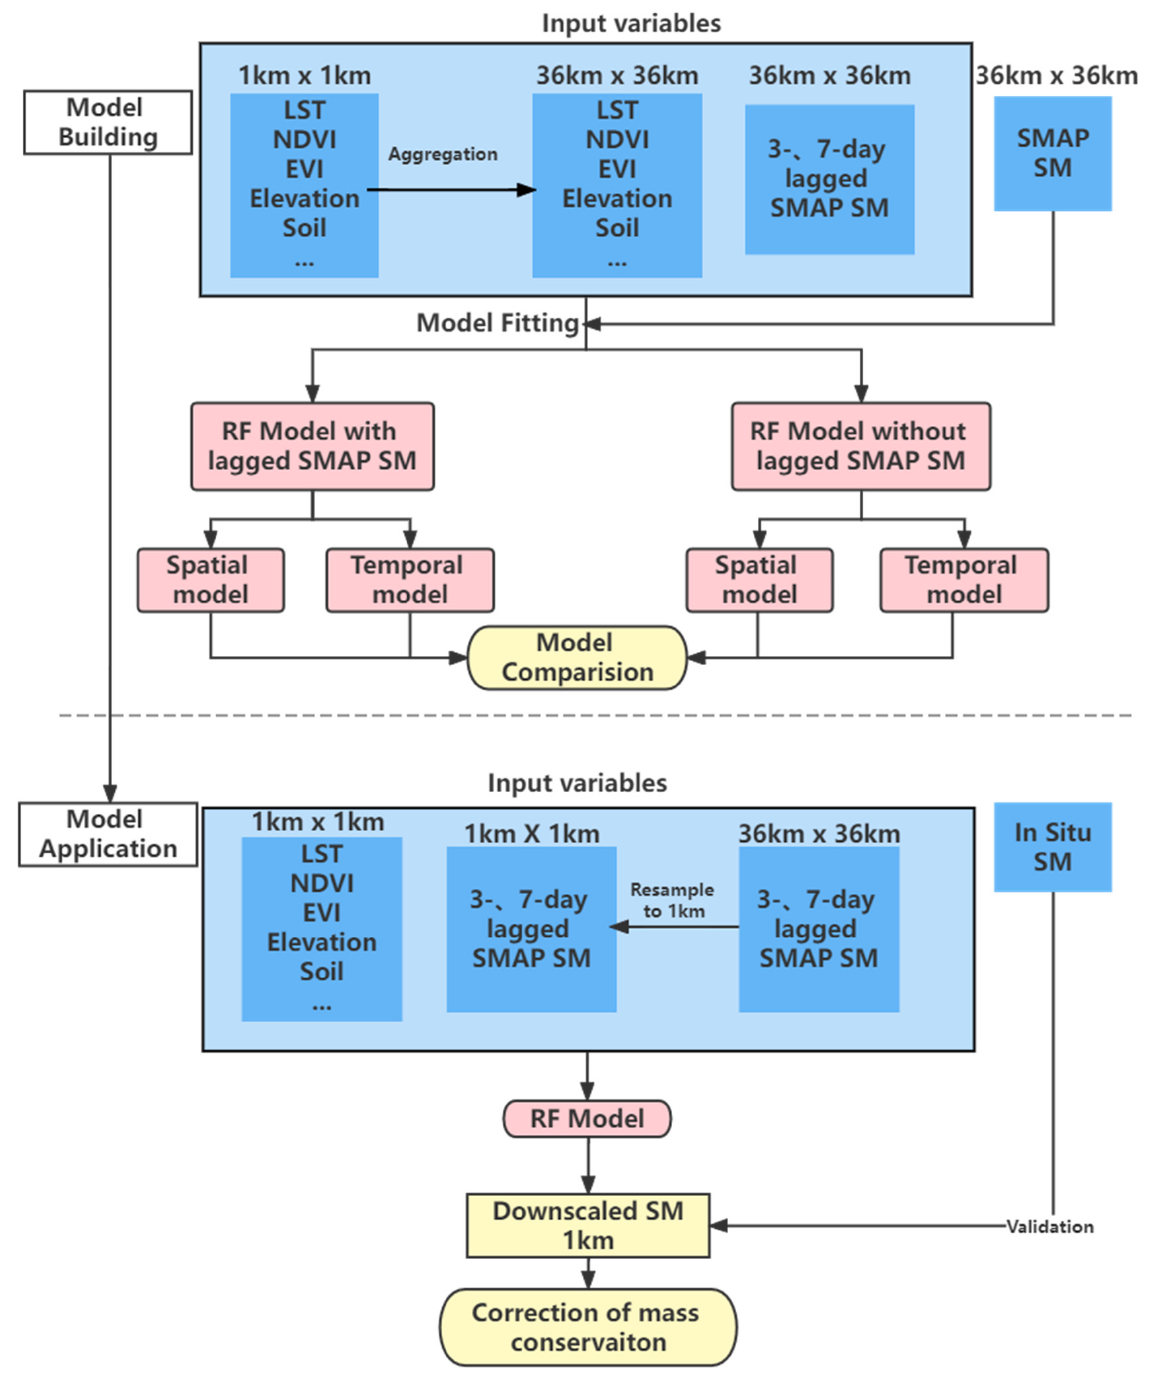
Figure 3. Flow chart of experiment. RF = random forest.